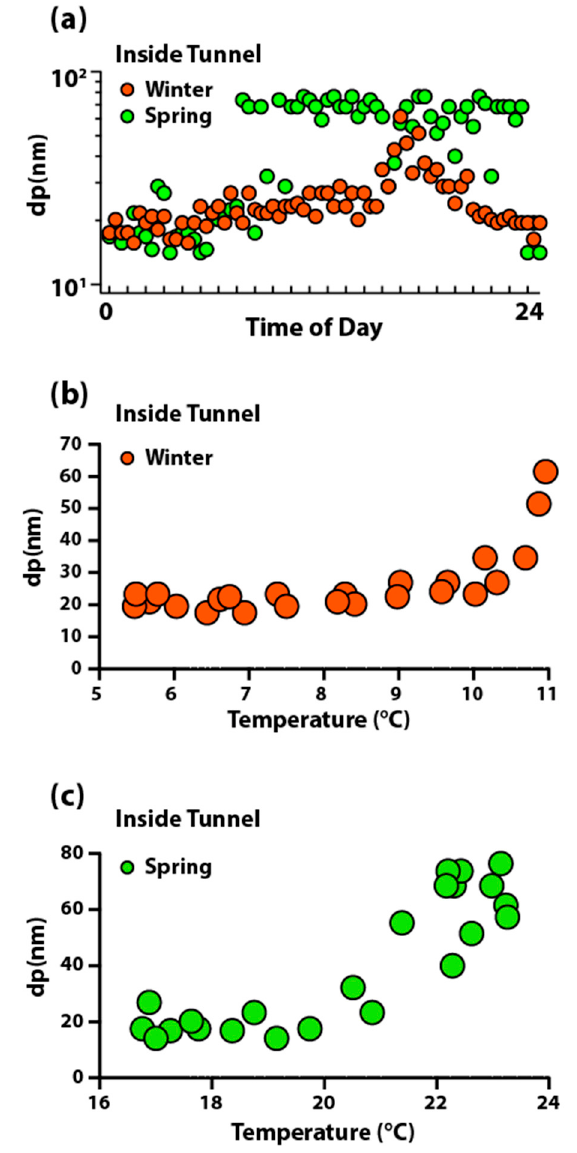
Figure 7. ( a ) Diurnal patterns of particle mode in the tunnel in winter and spring seasons and scatter plots between particle mode and tunnel temperature in ( b ) winter and ( c ) spring.